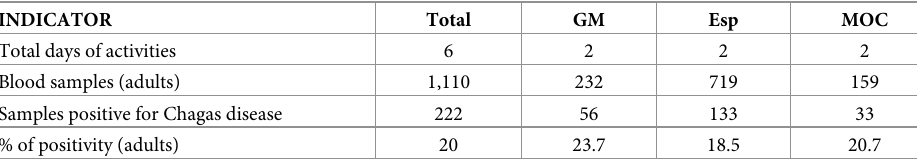
Table 3. Serodiagnosis survey during Chagas Express XXI